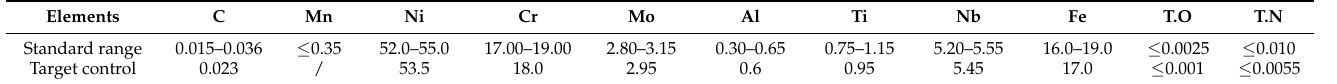
Table 2. Chemical composition of superalloy GH4169, wt%.